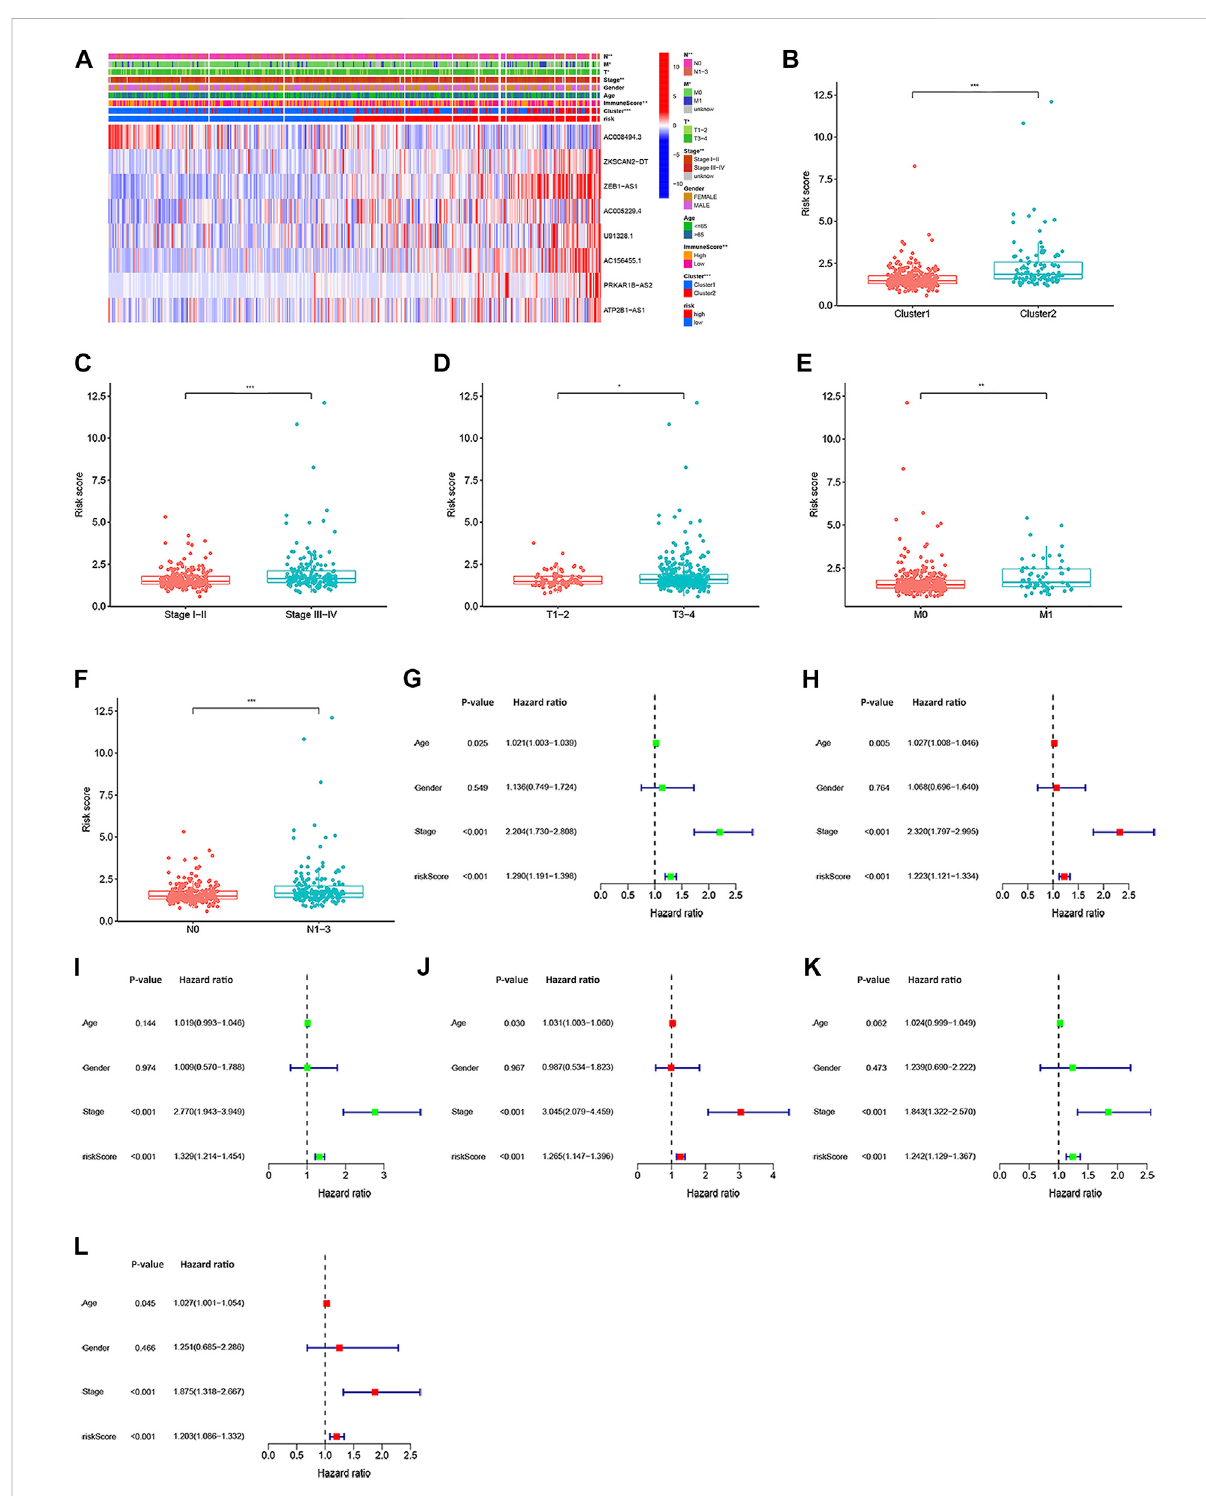
FIGURE 7 The association ofrisk score with clinicalcharacteristics,and univariateand multivariate Coxregression analyses for therisk score basedon the 8 m6A-related lncRNA signatures. (A) Heatmap of the correlation of 8 m6A-related lncRNA signatures with cluster 1/2 subtypes, immuneScore, and clinical characteristics. Different levels of risk score associated with pathologic-stage (B) , TMN staging (C – E) , and clusters (F) . Univariate Cox regression analysis and multivariate Cox regression analyses for the complete dataset (G,H) , respectively), training dataset [(I,J) , respectively] and testing dataset [(K,L) , respectively]. * p < 0.05; ** p < 0.01; *** p <